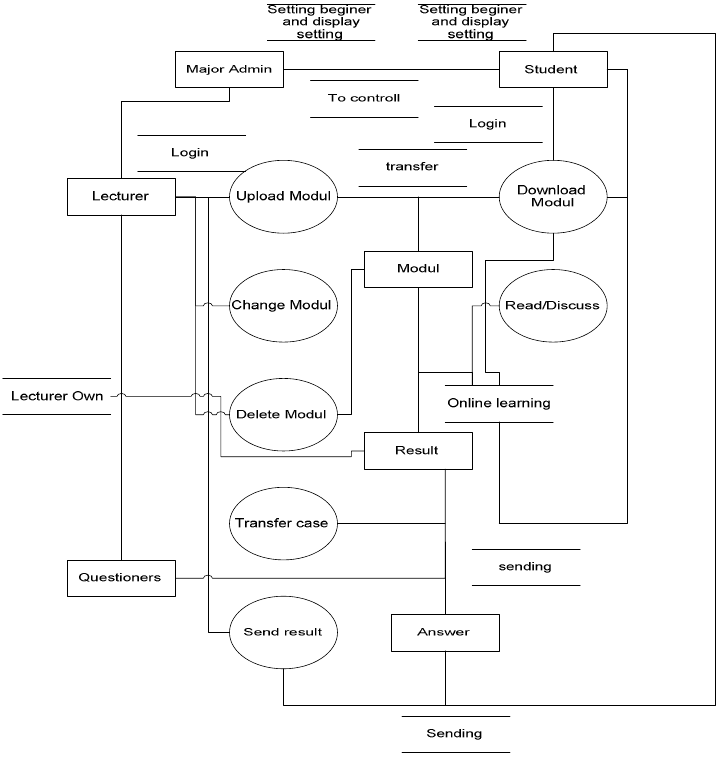
Figure 2. Data Flow